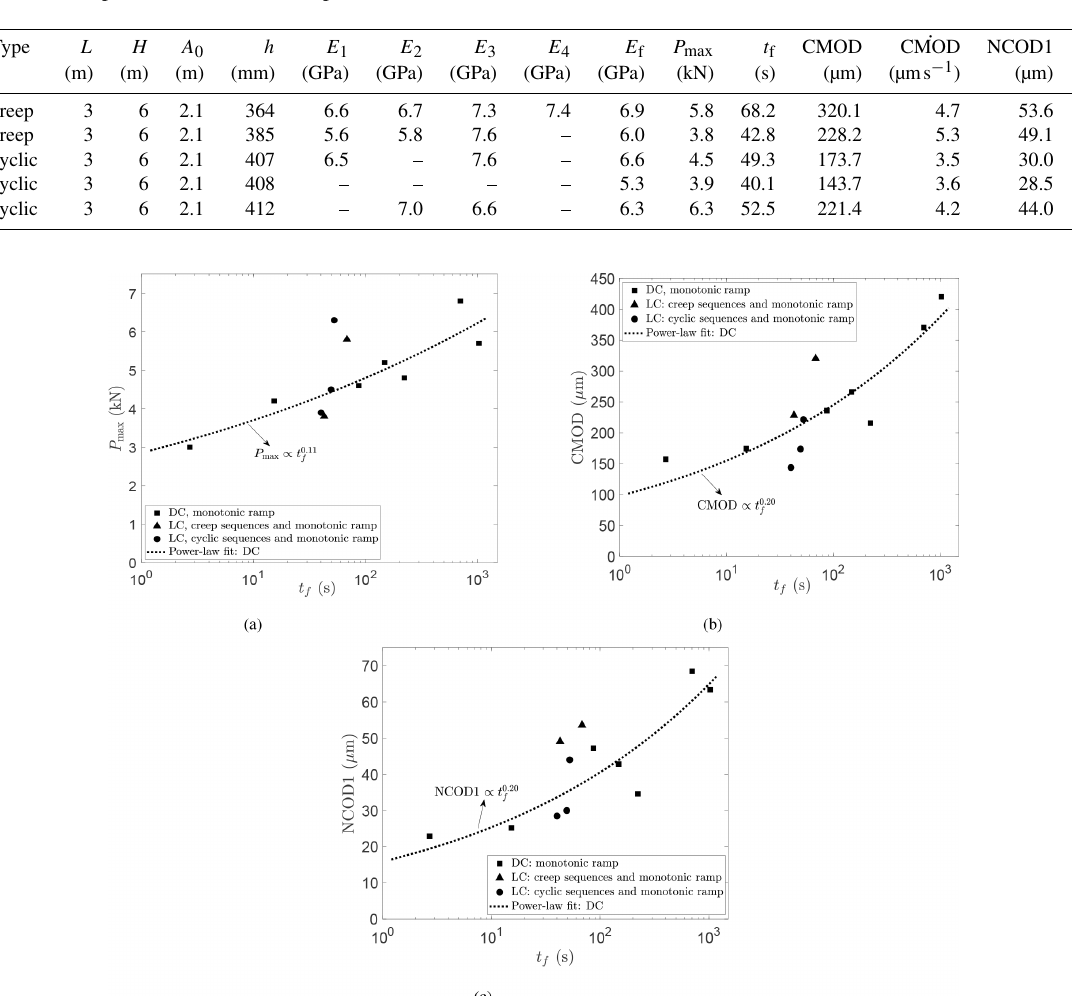
Figure 4. Experimental results for the (a) peak load P max , (b) crack mouth opening displacement CMOD, and (c) near-crack-tip opening displacement NCOD1 at crack growth initiation, as a function of time to failure t f for the monotonically loaded DC tests (Gharamti et al., 2021) and the creep/cyclic and monotonically loaded LC